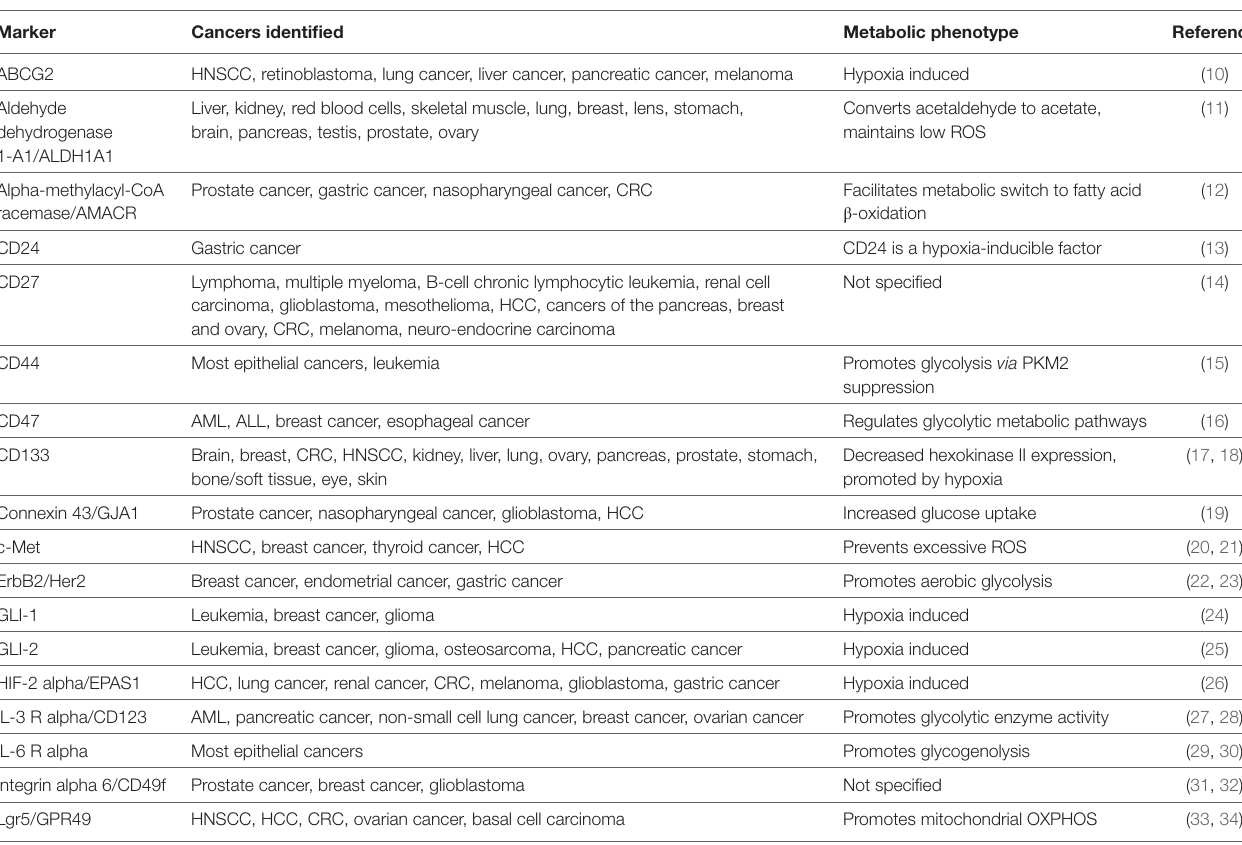
Table 1 | Biomarkers reported to characterize